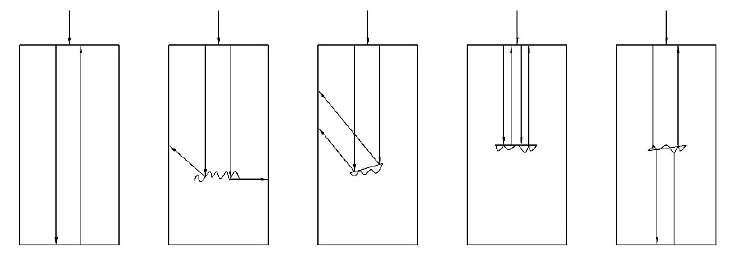
Figure 1. Several cases of acoustic wave transmitting in CTB specimen.